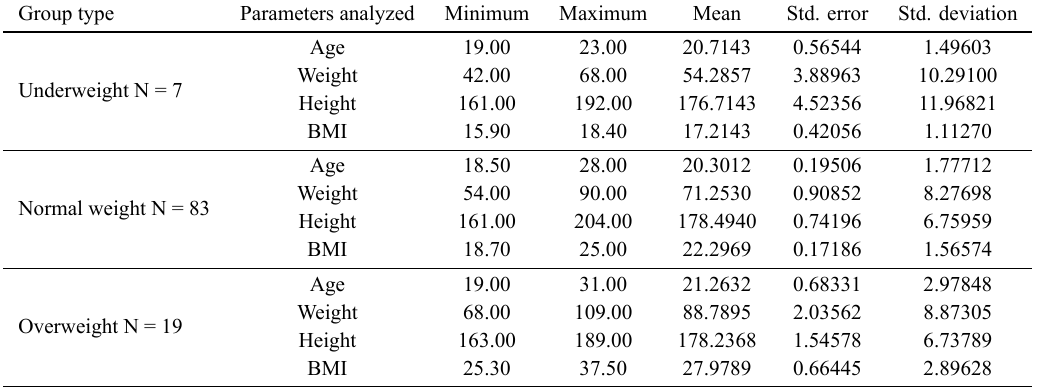
Table 1. Identification data of each analyzed group (age, anthropometric indicators and BMI values). Group